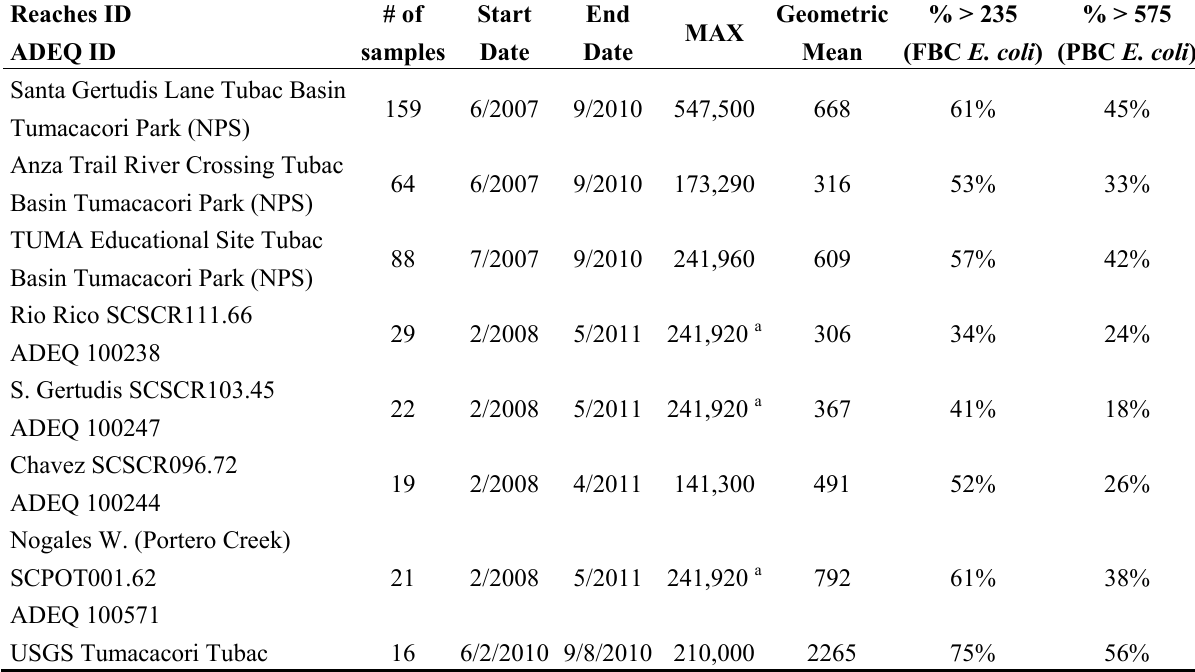
Table 5. E. coli concentration (cfu/100 mL) summary from in-stream sampling locations in the Upper Santa Cruz